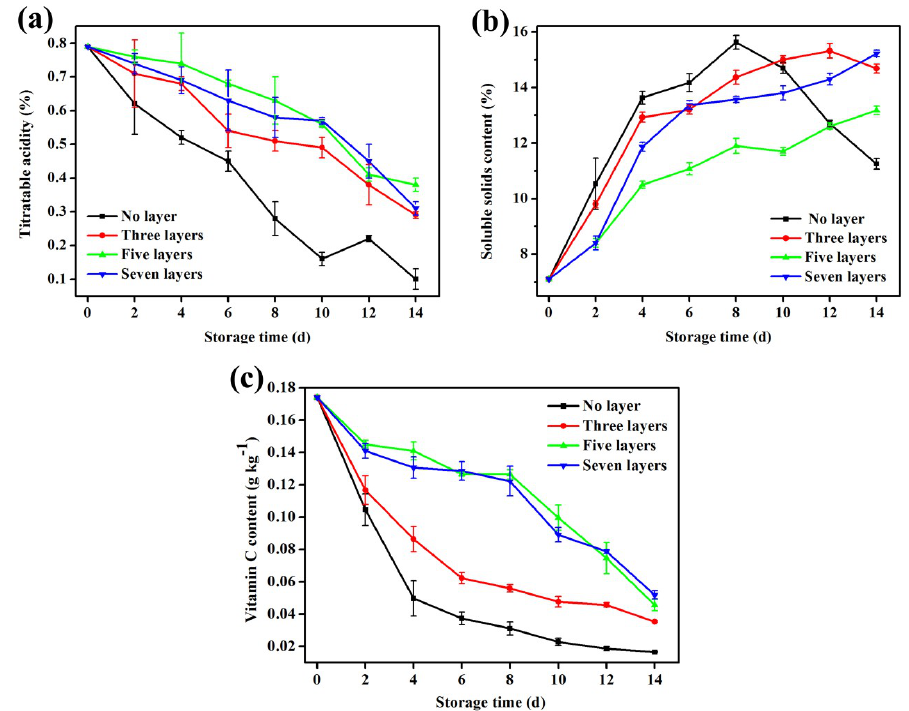
Figure 6. ( a ) Changes in the titratable acidity during mango storage; ( b ) changes in the soluble solid contents during mango storage; ( c ) changes in vitamin C during mango storage. The error bars represent the standard deviation of three